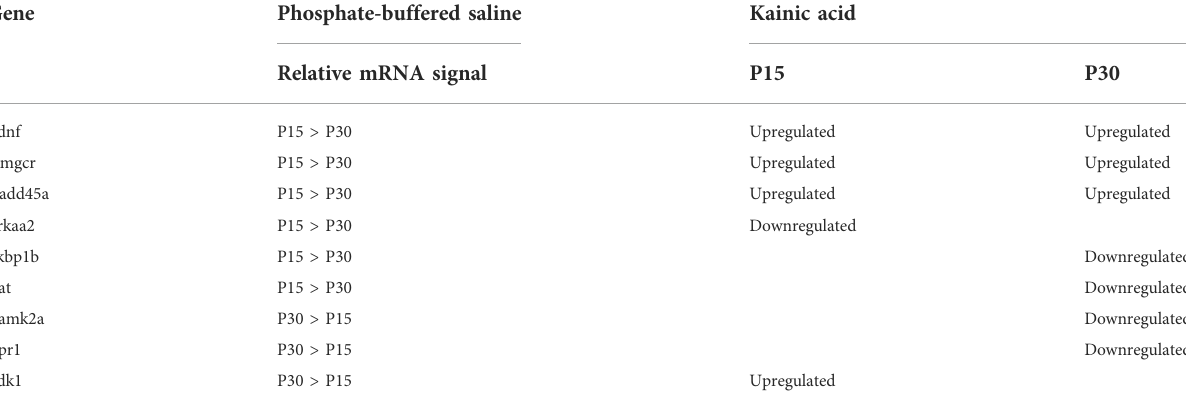
TABLE 4 Thirteen representative pathways for differentially expressed genes in P15 and P30 after KA-SE.